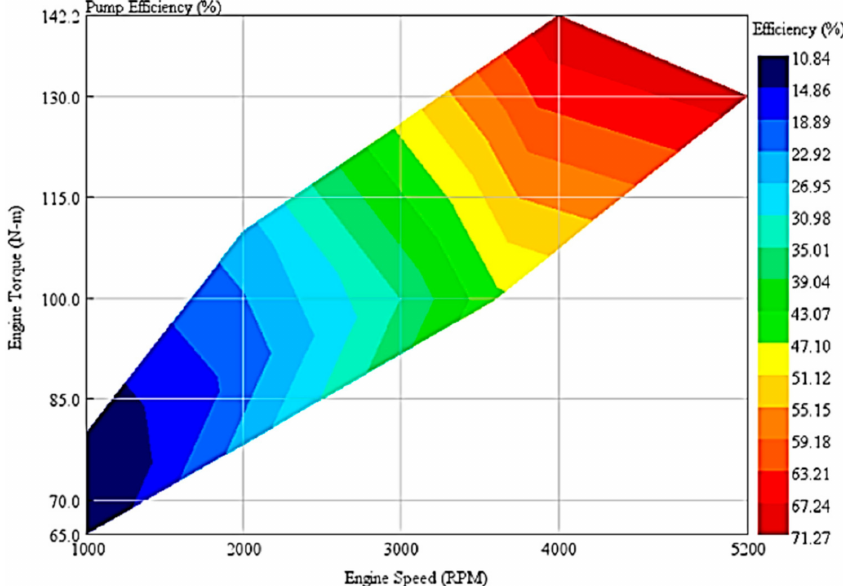
Figure 19. Pump E ffi ciency Contour